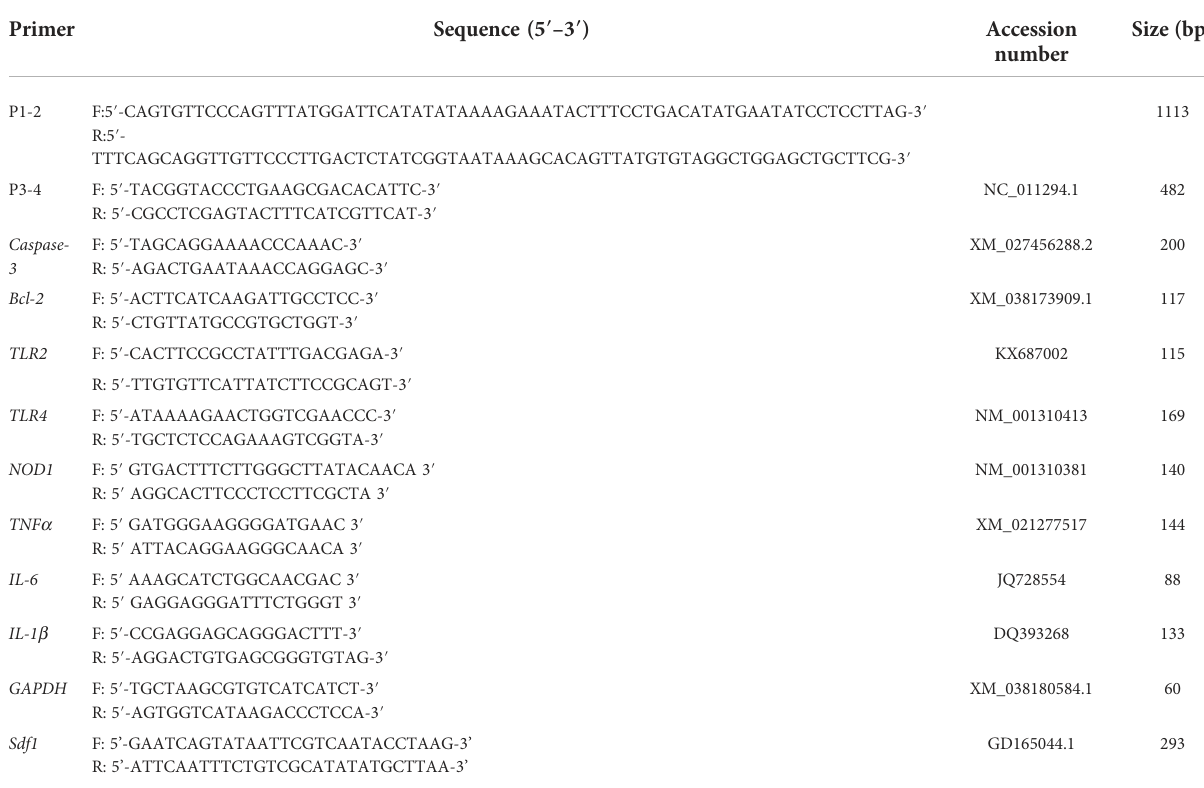
TABLE 3 Primers used for qRT-PCR analysis of apoptosis and immune response genes during Salmonella entertidis infection.